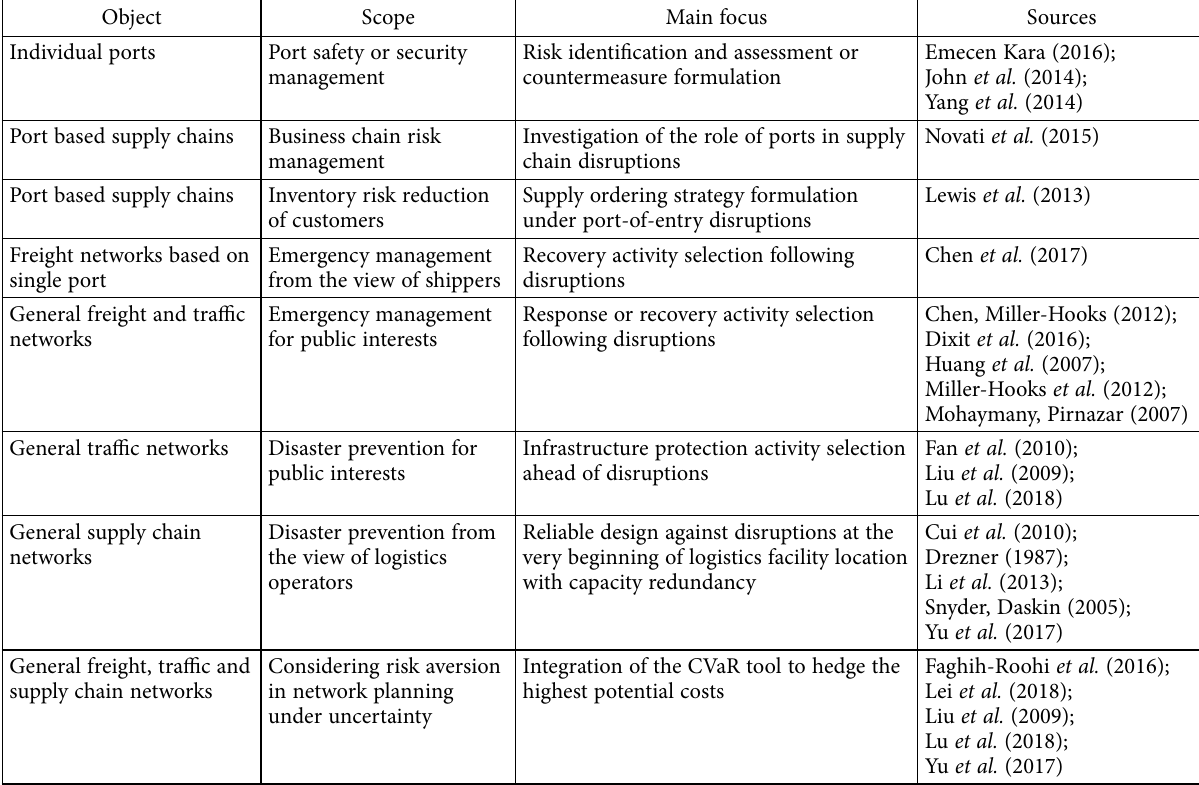
Table 1. Key features of relevant